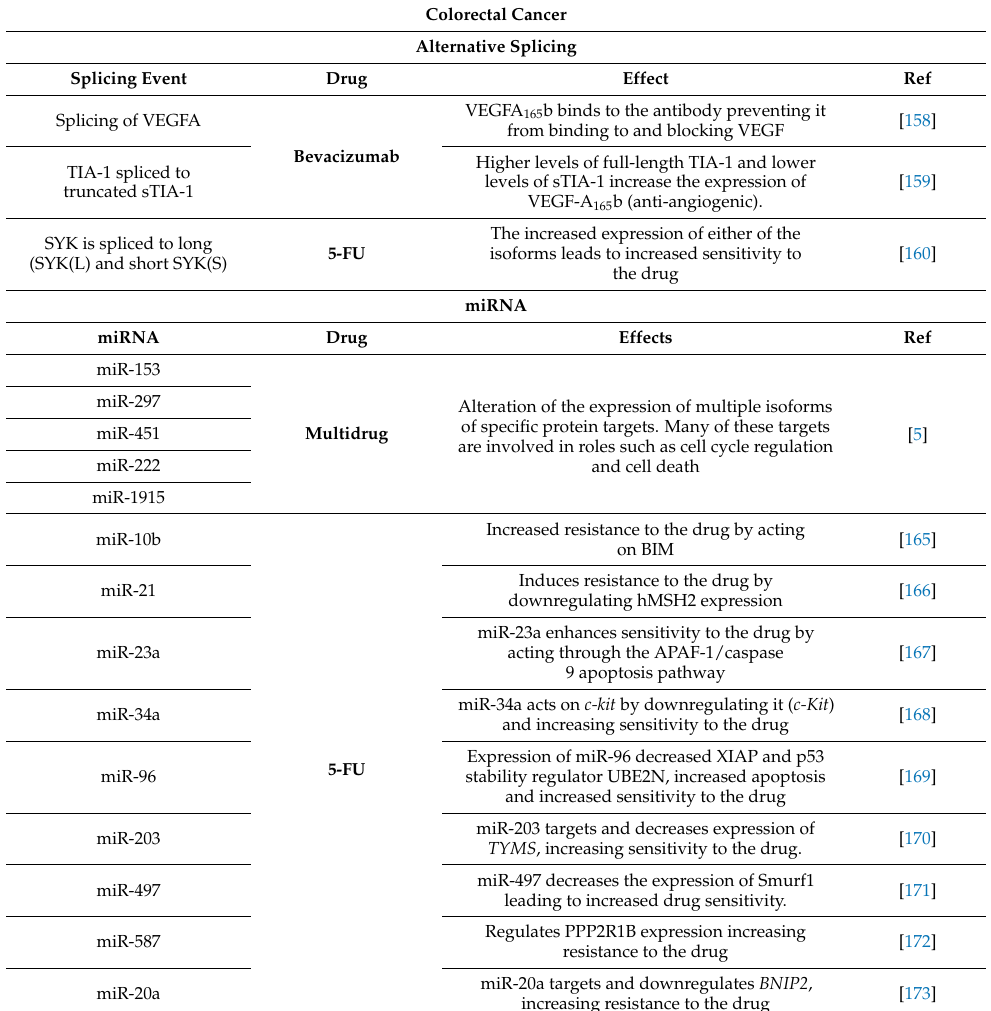
Table 6. Alternative splicing events and miRNAs involved in drug resistance in colorectal cancer